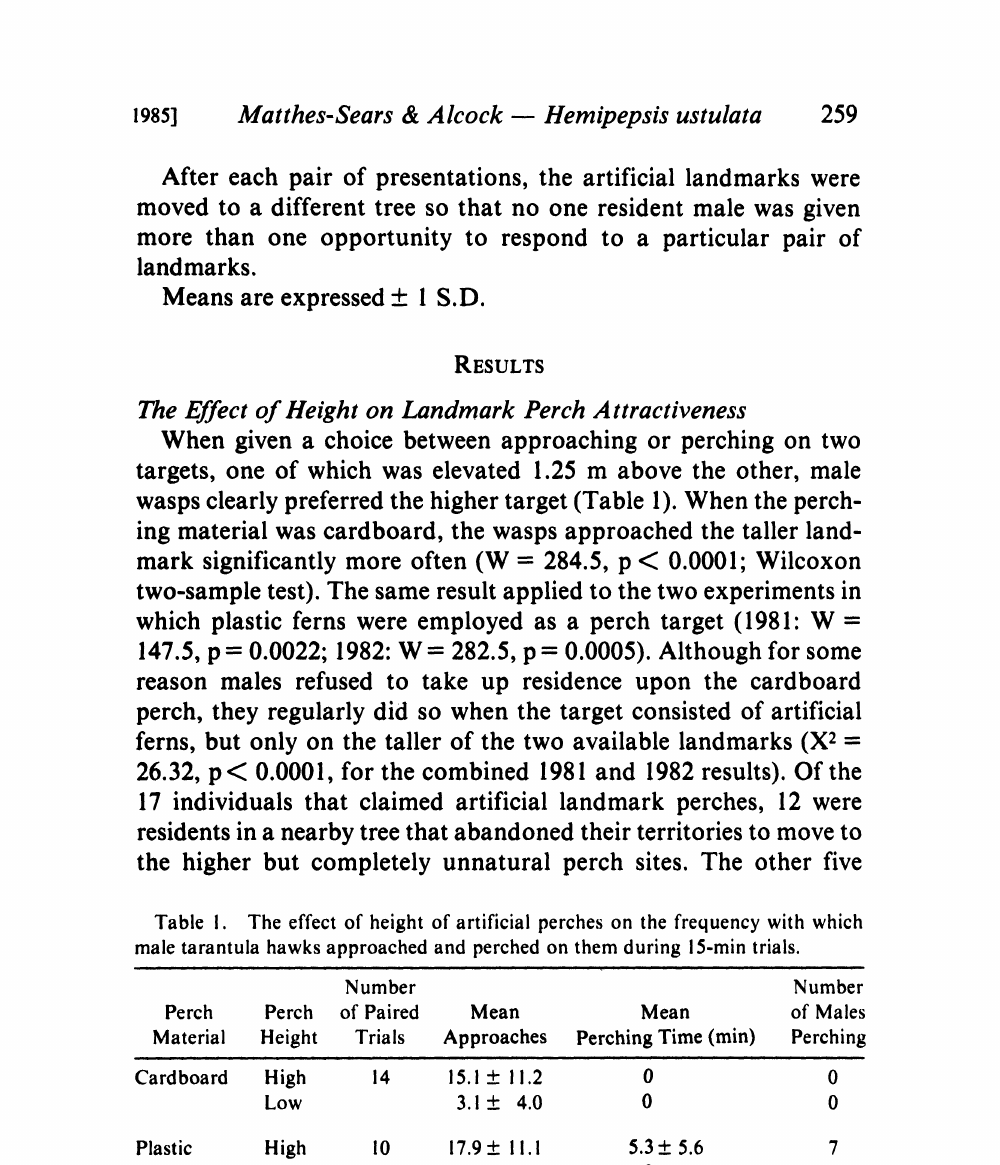
Table I. The effect of height of artificial perches on the frequency with which male tarantula hawks approached and perched on them during 15-min trials. Number Number